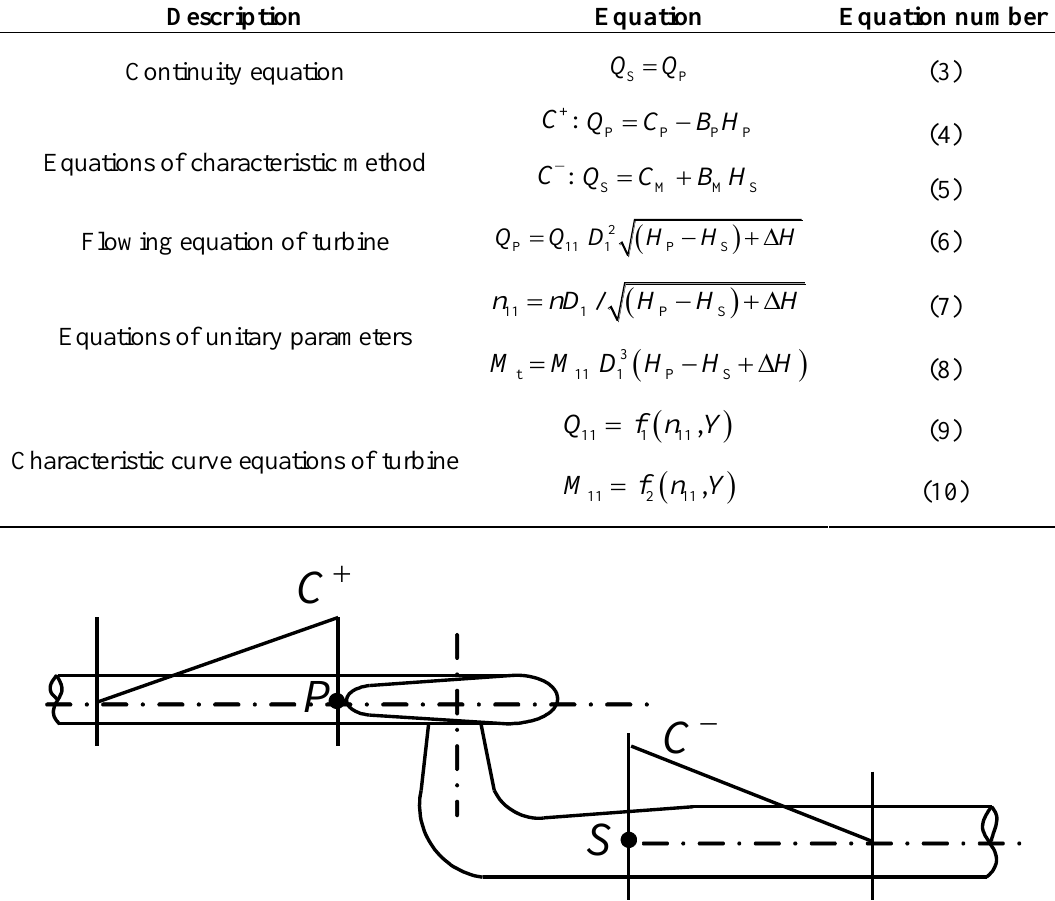
Table 1. Equations of the mathematical turbine models.